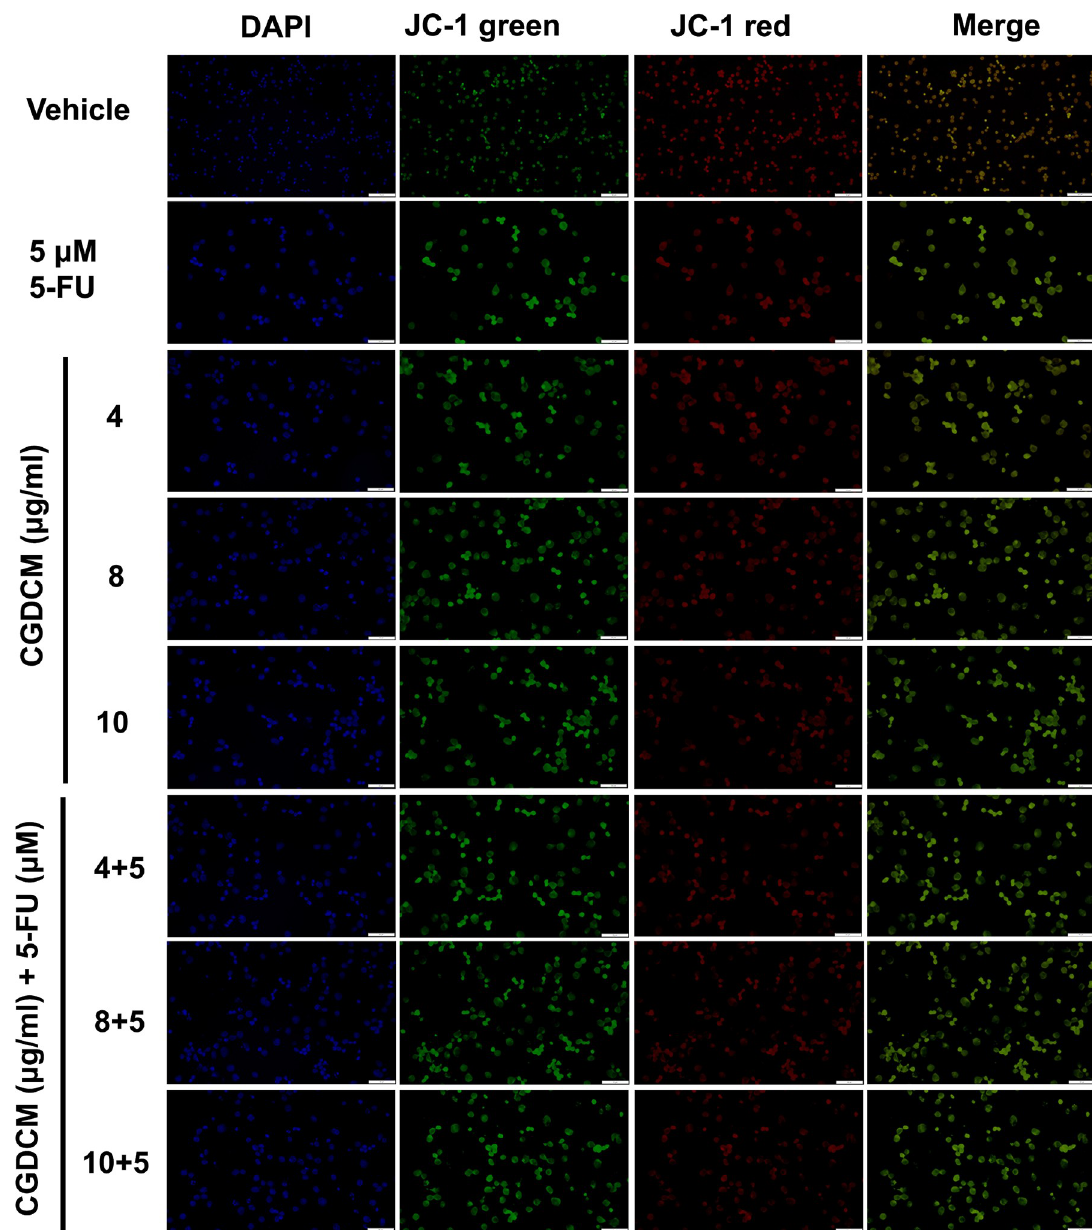
Fig 4. Combination effects of CGDCM and 5-FU on mitochondrial membrane potential of HCT116 cells. Cells were treated with CGDCM, 5-FU, and combinations of CGDCM (4, 8, and 10 μ g/mL) with 5-FU (5 μ M or 0.65 μ g/mL) for 24 h. JC-1 staining was visualized by fluorescence microscopy; bars = 100 μ m. Abbreviations: CGDCM, C . gigantea dichloromethane extract; 5-FU, 5-fluorouracil; DAPI, 4 0 ,6-Diamidino-2-phenylindole dihydrochloride.